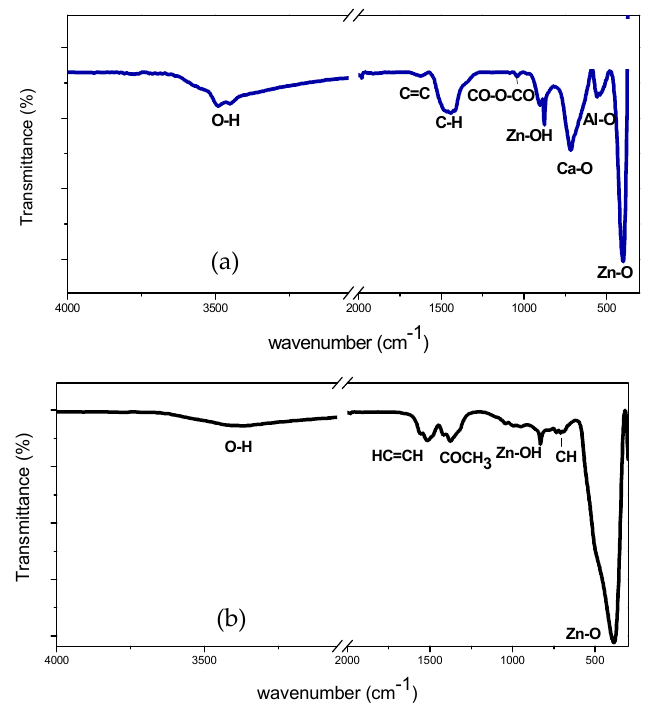
Figure 3. ATR-FTIR spectrum of: ( a ) ZnO; ( b ) 3Al,3Ca doped ZnO.